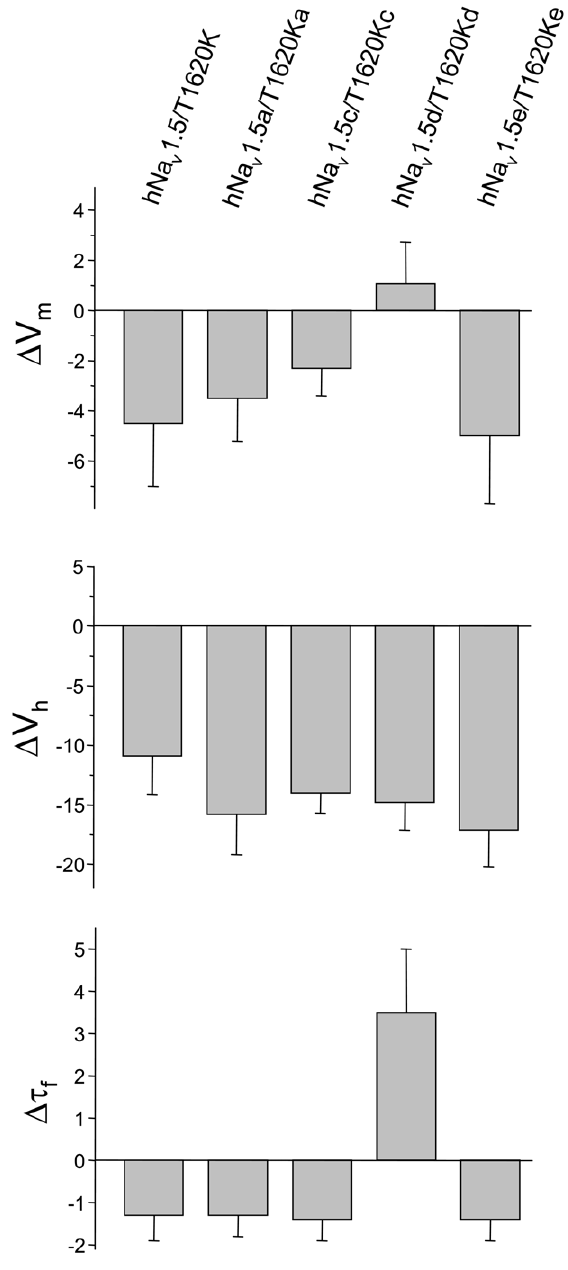
Figure 7. Relative alterations of mid-activation potentials V m , mid-inactivation potentials V h , and recovery time constants t f . Mutation T1620K caused similar shifts in the background of most splice variants, except for hNa v 1.5d. Bars indicate S.E.M.